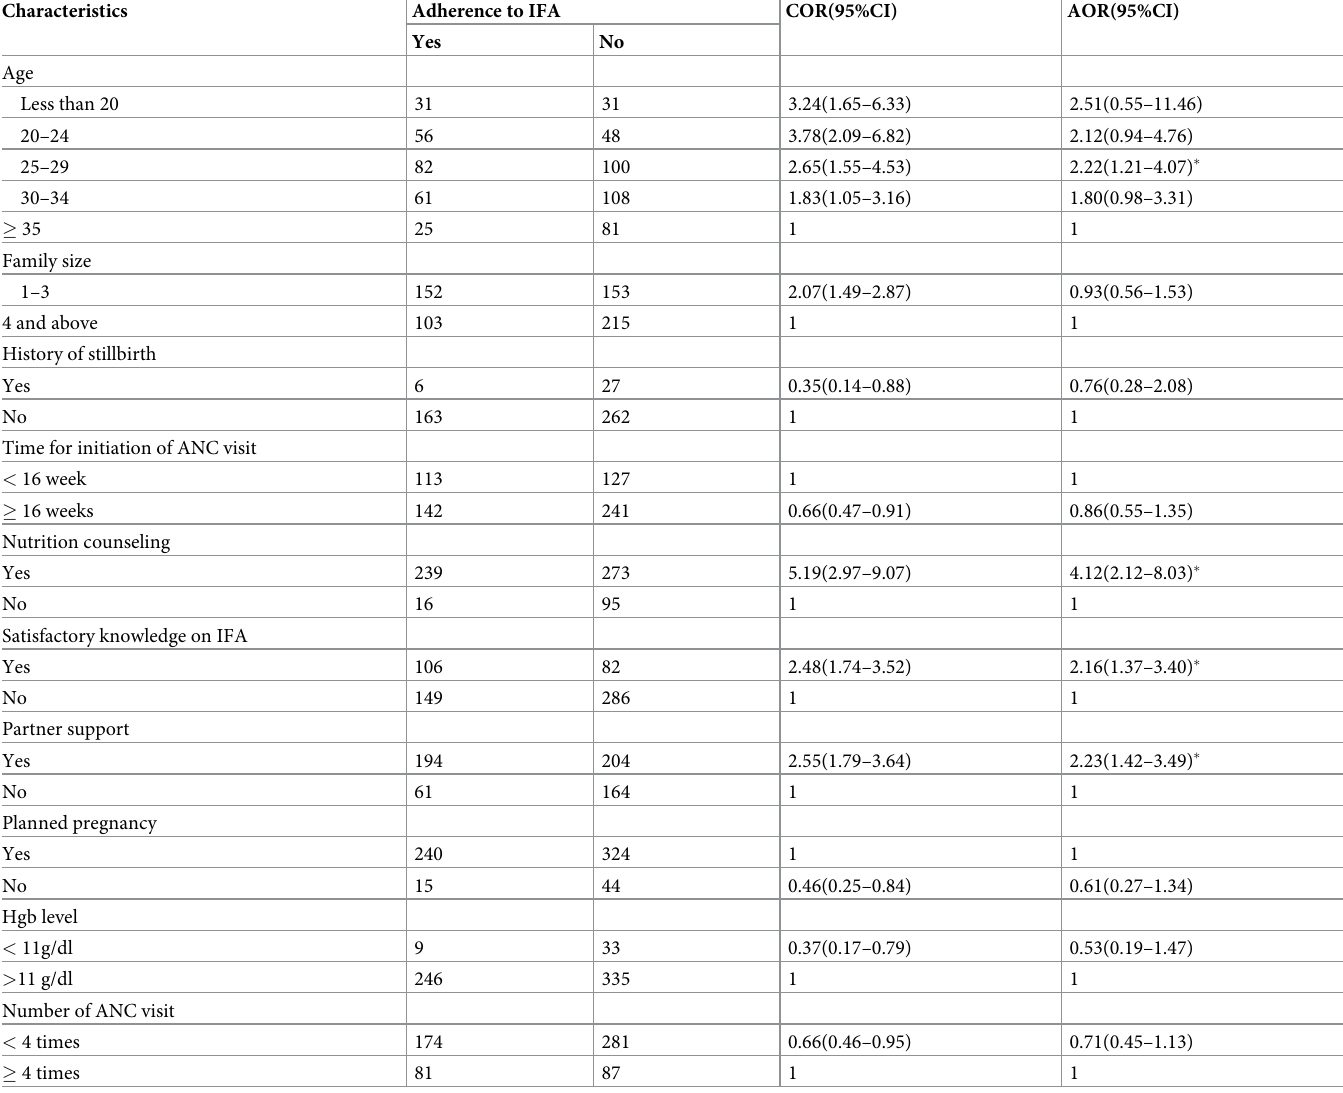
Table 5. Bivariable and multivariable binary logistic regression of factors associated with adherence to iron-folic acid supplement among ANC attending pregnant mothers in governmental health institutions of Adwa town, northern Ethiopia, 2018.